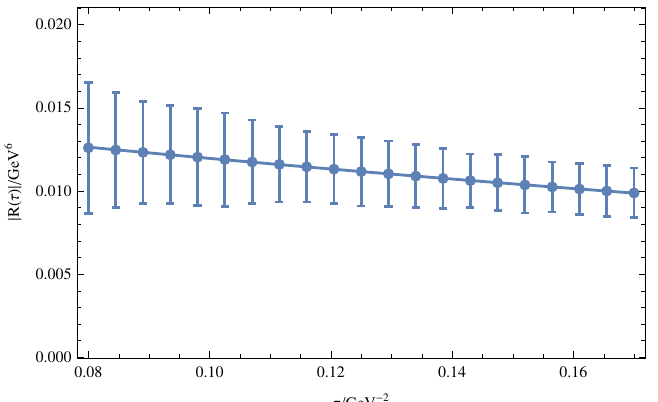
Figure 7 . QCDSR minimum- (cid:31) 2 (cid:12)t for the ss and glueball mixed state: the dots represent QCD side of the master equation (2.9), and the middle line represents phenomenological side of (2.9). The error bars are induced by 10% uncertainty of the phenomenological parameters in of the phenomenological parameters of table